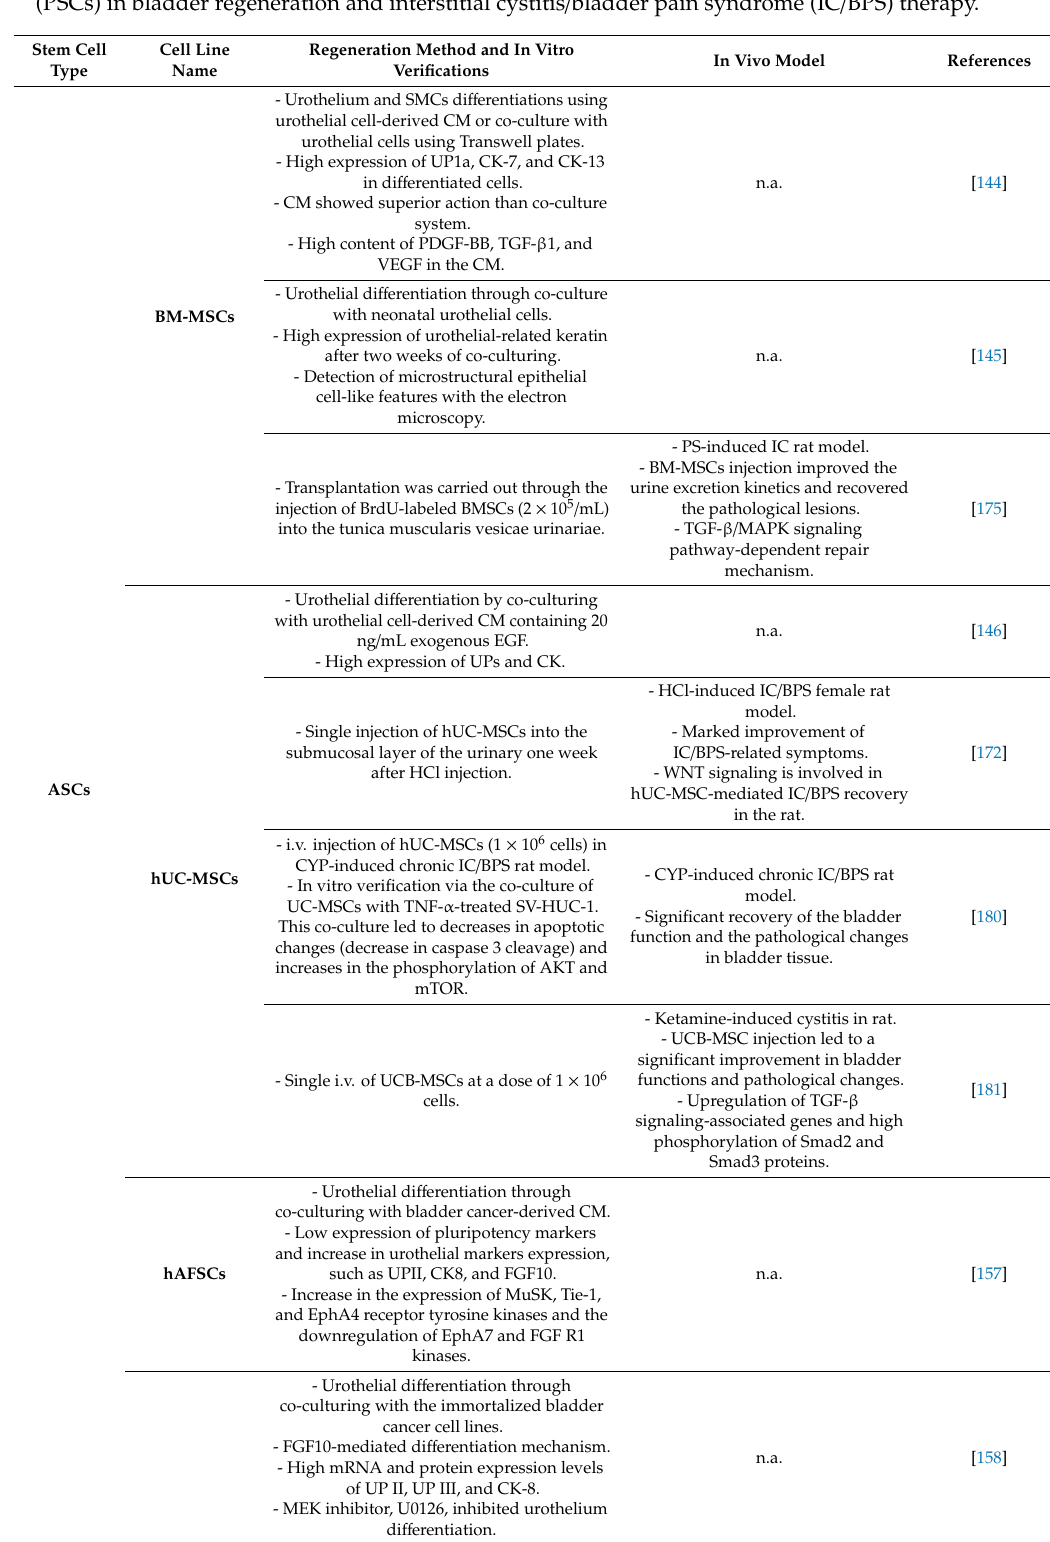
Table 1. Table summarizing the implications of adult stem cells (ASCs) and pluripotent stem cells (PSCs) in bladder regeneration and interstitial cystitis / bladder pain syndrome (IC / BPS) therapy. Stem Cell